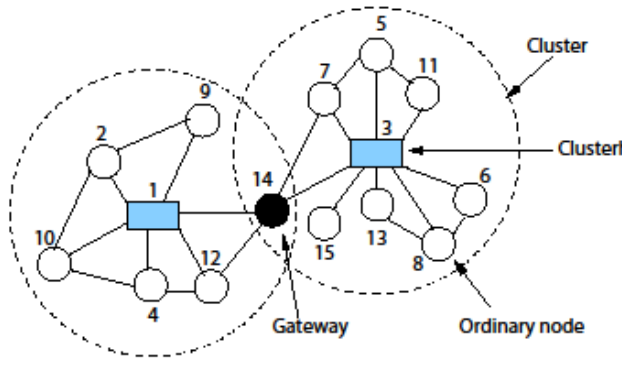
Figure 2. Lowest-ID and Highest Degree Heuristics